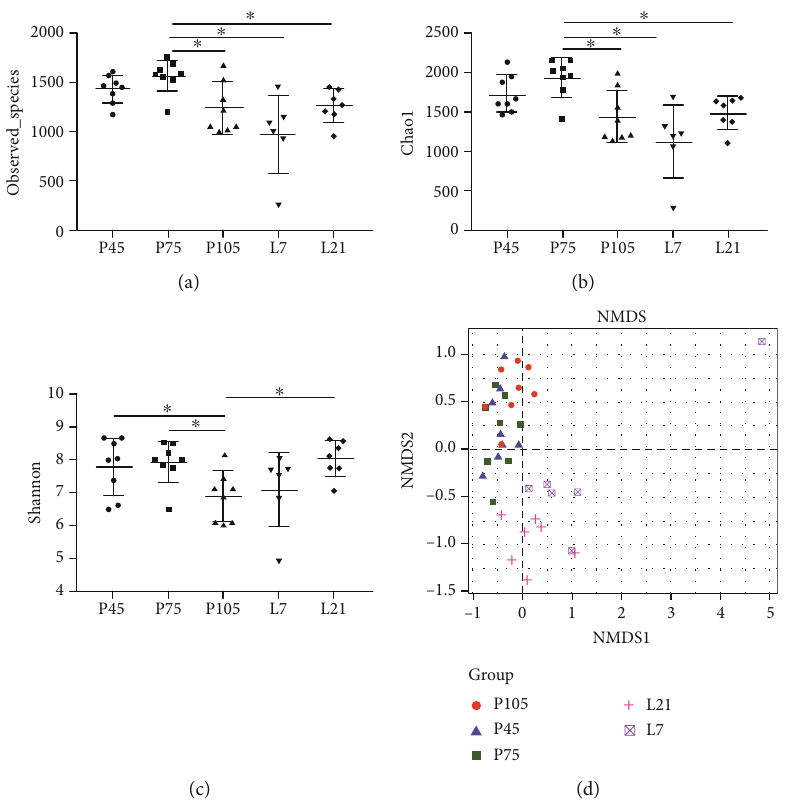
Figure 3: Fecal microbiota diversity of sows at di ff erent stages of pregnancy and lactation. The bacterial diversity was estimated by observed_ species (a), Chao1 (b), Shannon index (c), and nonmetric multidimensional scaling (NMDS) of bacterial community (d). Data show the means ± SEM . n = 6 ‐ 8 per